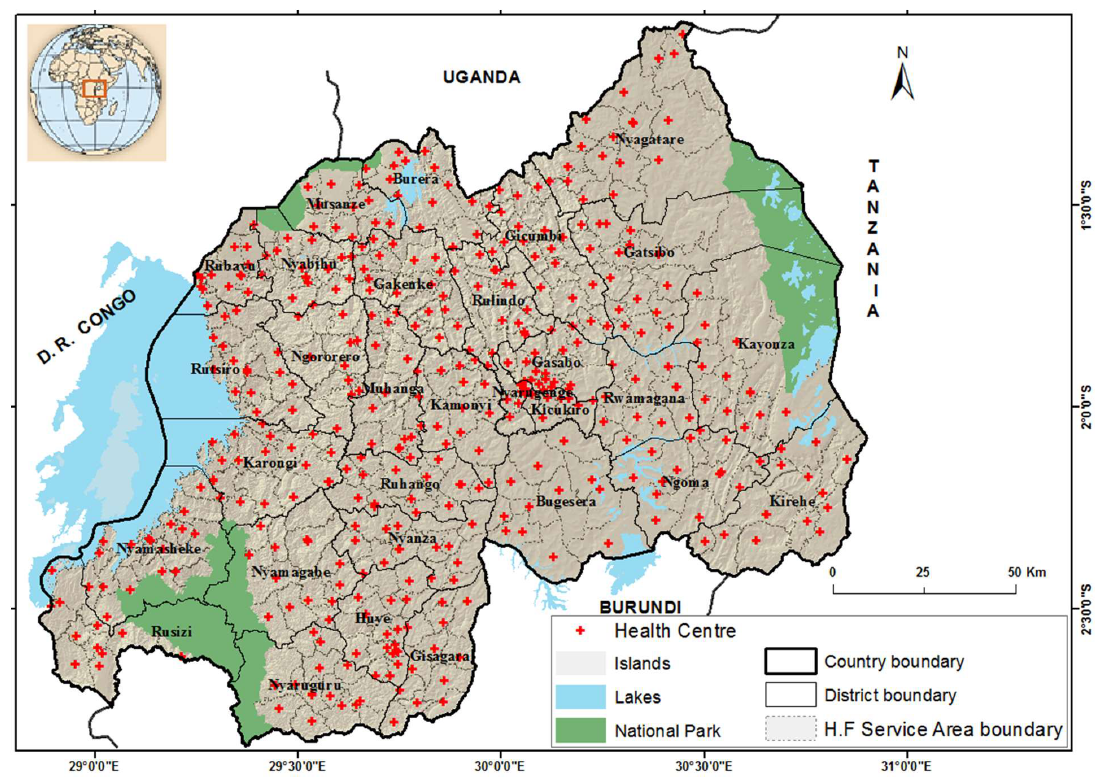
Figure 1. District boundaries, primary health facility locations as provided by RBC–GIS unit and Health Facility Service Area (HFSA) boundaries delineated using spatial allocation tools and data from the community-based health insurance scheme in 2010.